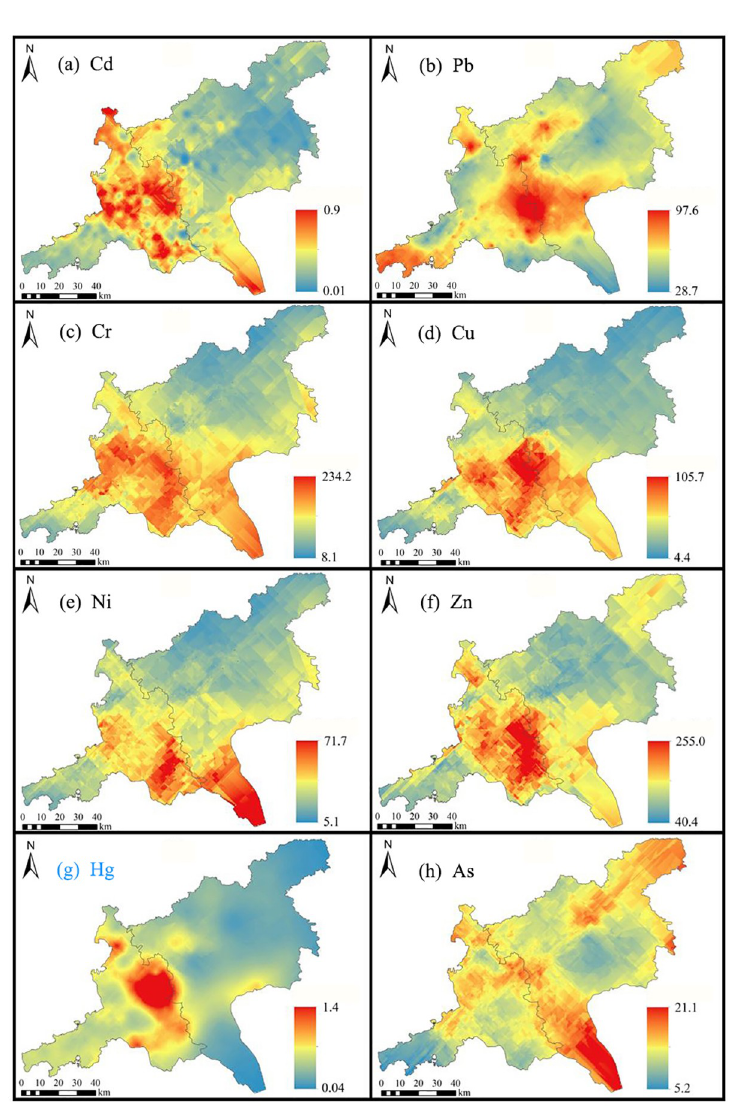
Fig 2. Spatial distribution of heavy metal content in soil. (a) Cd, (b) Pb, (c) Cr, (d) Cu, (e) Ni, (f) Zn, (g) Hg, (h)